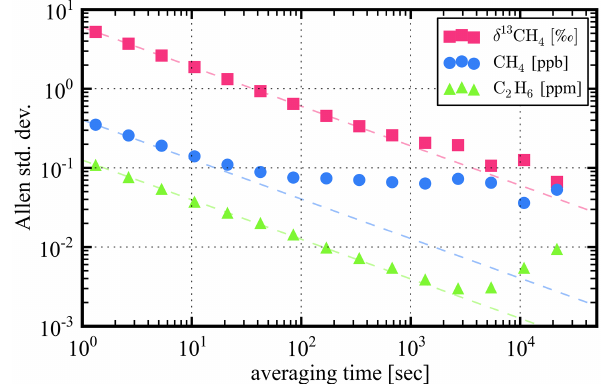
Figure 2. Allan deviation for δ 13 CH 4 , CH 4 , and C 2 H 6 collected over 18h, in units of ‰, ppb, and ppm, as noted in the legend. The precision of the instrument is about 0.4ppb for CH 4 in a 1.2s mea- surement, and below 1.0‰ for δ 13 CH 4 in a minute of averaging. The ethane measurement precision is about 20ppb in 1min. The latter two quantities follow a square root averaging law for 1h or more of